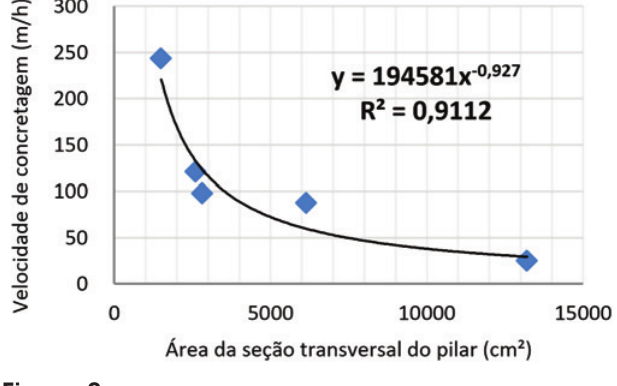
Figura 8 Relação entre velocidade de concretagem medida in loco e área da seção transversal dos pilares